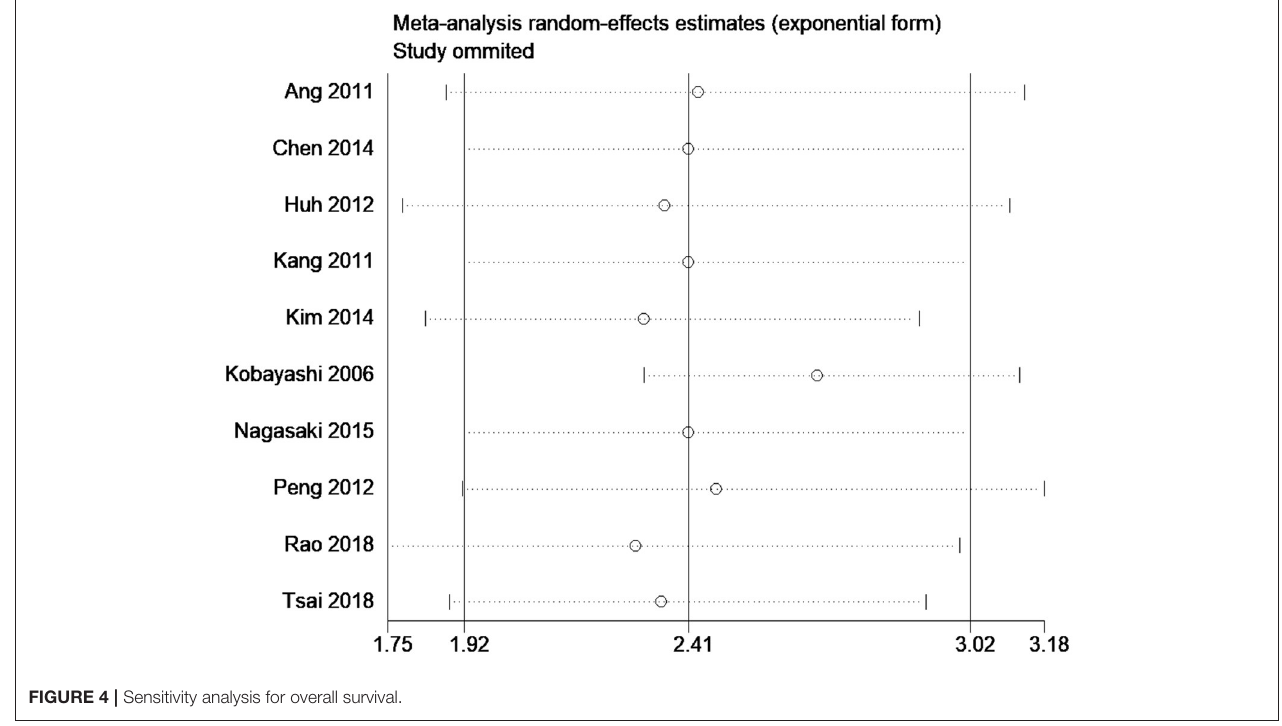
FIGURE 4 | Sensitivity analysis for overall survival.